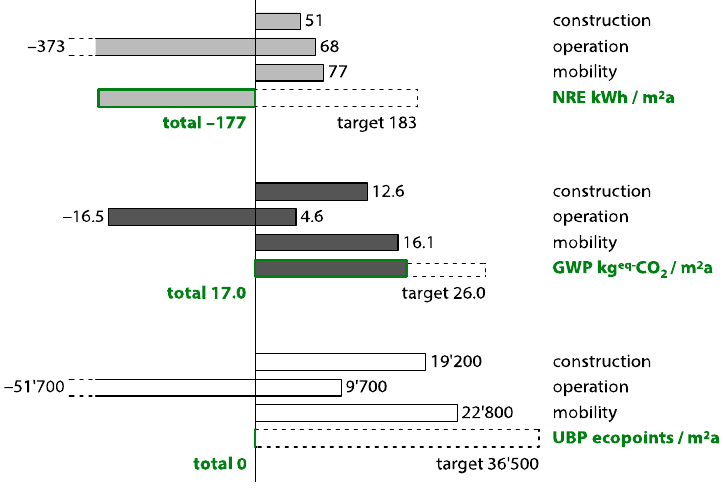
Figure 6. Estimated performances in non-renewable primary energy (NRE), global warming potential (GWP) and Umweltsbelastungspunkte (UBP) eco-points.